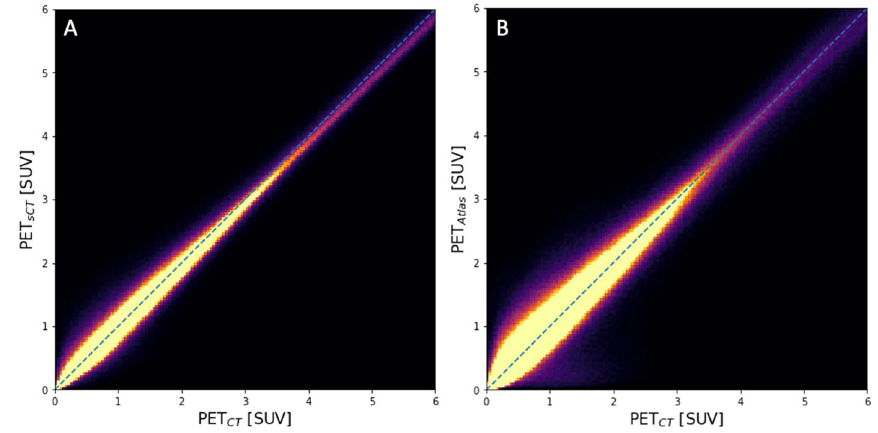
Fig. 3 Joint histograms for A PET CT and PET sCT , and B PET CT and PET Atlas of voxels within the body contour as well as lung, bone, and liver